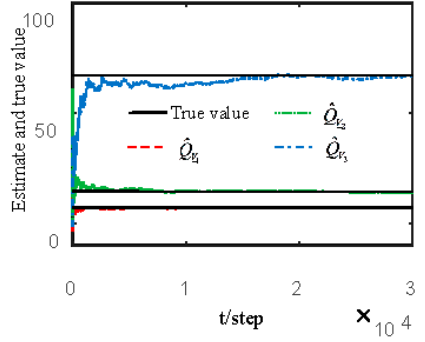
Sensors 2019 , 19 , x FOR PEER REVIEW 16 of 19